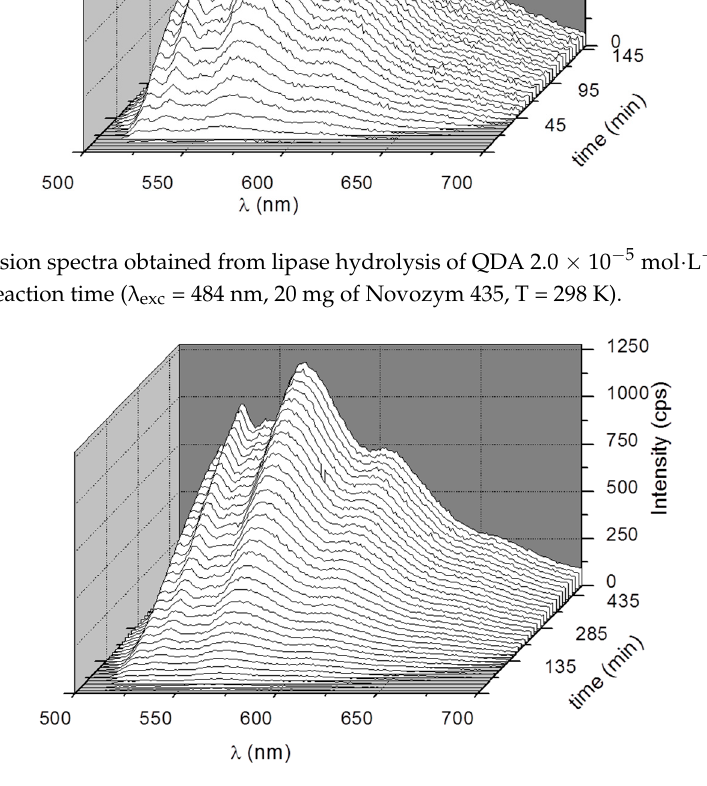
Figure 3. Emission spectra obtained from lipase hydrolysis of QDB 2.0 × 10 − 5 mol ∙ L − 1 in hexane as a function of reaction time ( λ exc = 484 nm, 20 mg of Novozym 435, T = 298 K).